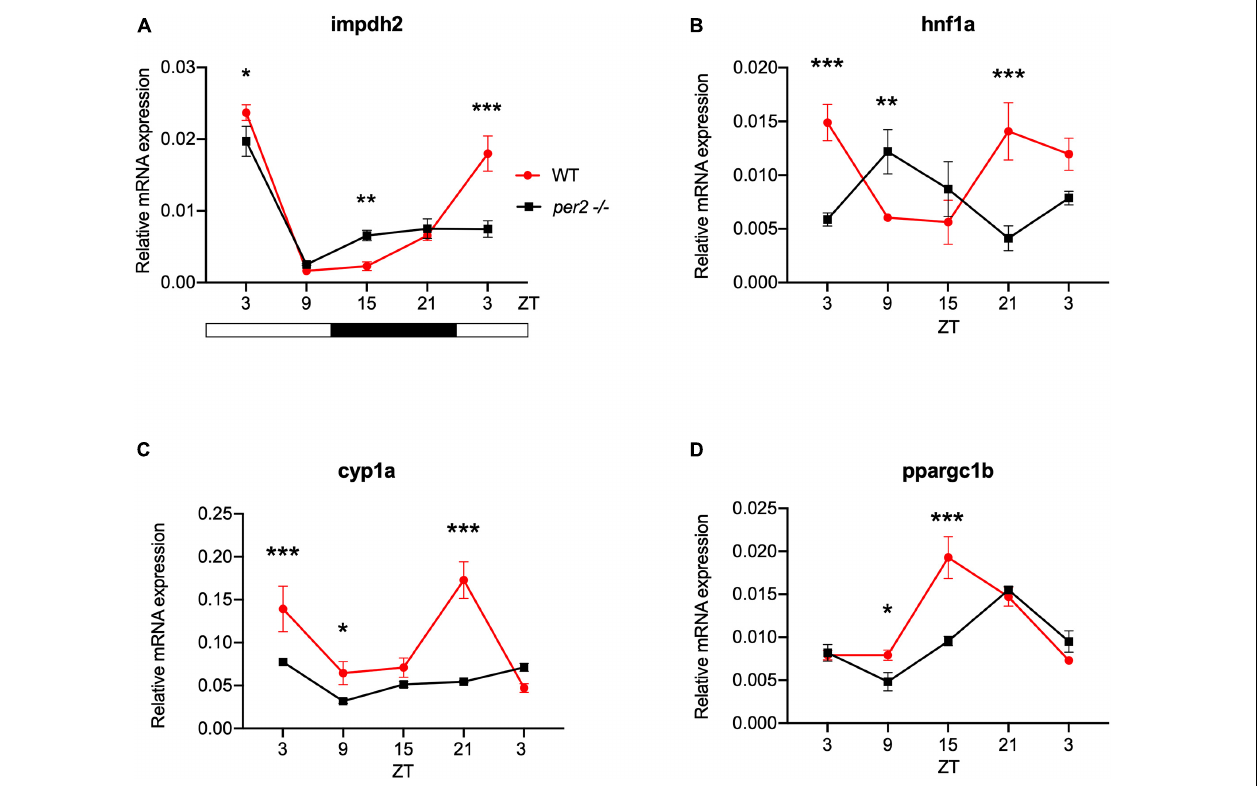
FIGURE 6 | Per2 knockout alters the rhythmic mRNA expression of regulators of key physiological hepatic processes in the adult zebrafish liver. qRT-PCR analysis of expression levels of four CCGs (A) impdh2, (B) hnf1a, (C) cyp1a, and (D) ppargc1b in WT and per2 KO liver. Sets of 4 WT and per2 KO fishes (each set containing two males and two females) were maintained under LD cycle (14 h light-10 h dark) conditions, livers were dissected and pooled for RNA extraction at 6-h intervals during a sampling window of 24 h. Mean mRNA relative expression ( n = 2–3) ± SD is plotted on the y -axis; zeitgeber time (ZT) is plotted on the x -axis. Zeitgeber times are indicated for each sample. ZT0 corresponds to lights-on, ZT14 to lights-off. A change in rhythm was observed for impdh2 , hnf1a, cyp1a and ppargc1b , as determined by a significant ANOVA Genotype × Time interaction effect for all genes ( p < 0.01, see Table 1 ). Furthermore, hnf1a exhibited a 12 h phase delay, and ppargc1b exhibited a 6 h phase delay. Asterisks represent levels of significance in comparing the two genotypes at each time point individually, corrected by Sidak’s method (*** p < 0.001, ** p < 0.01, * p <